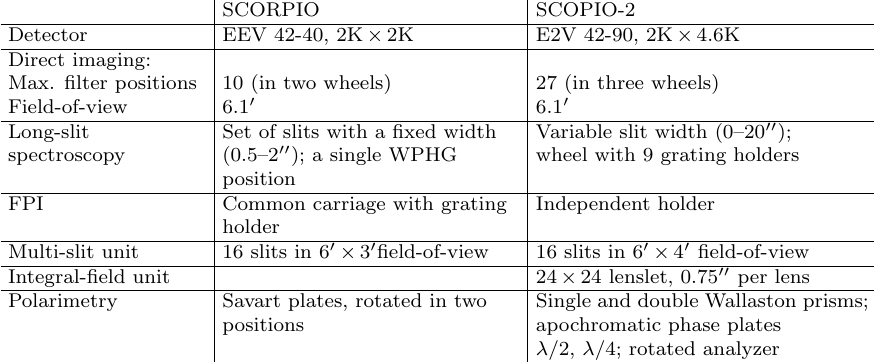
Table 1. Comparision of the old and new SCORPIO focal